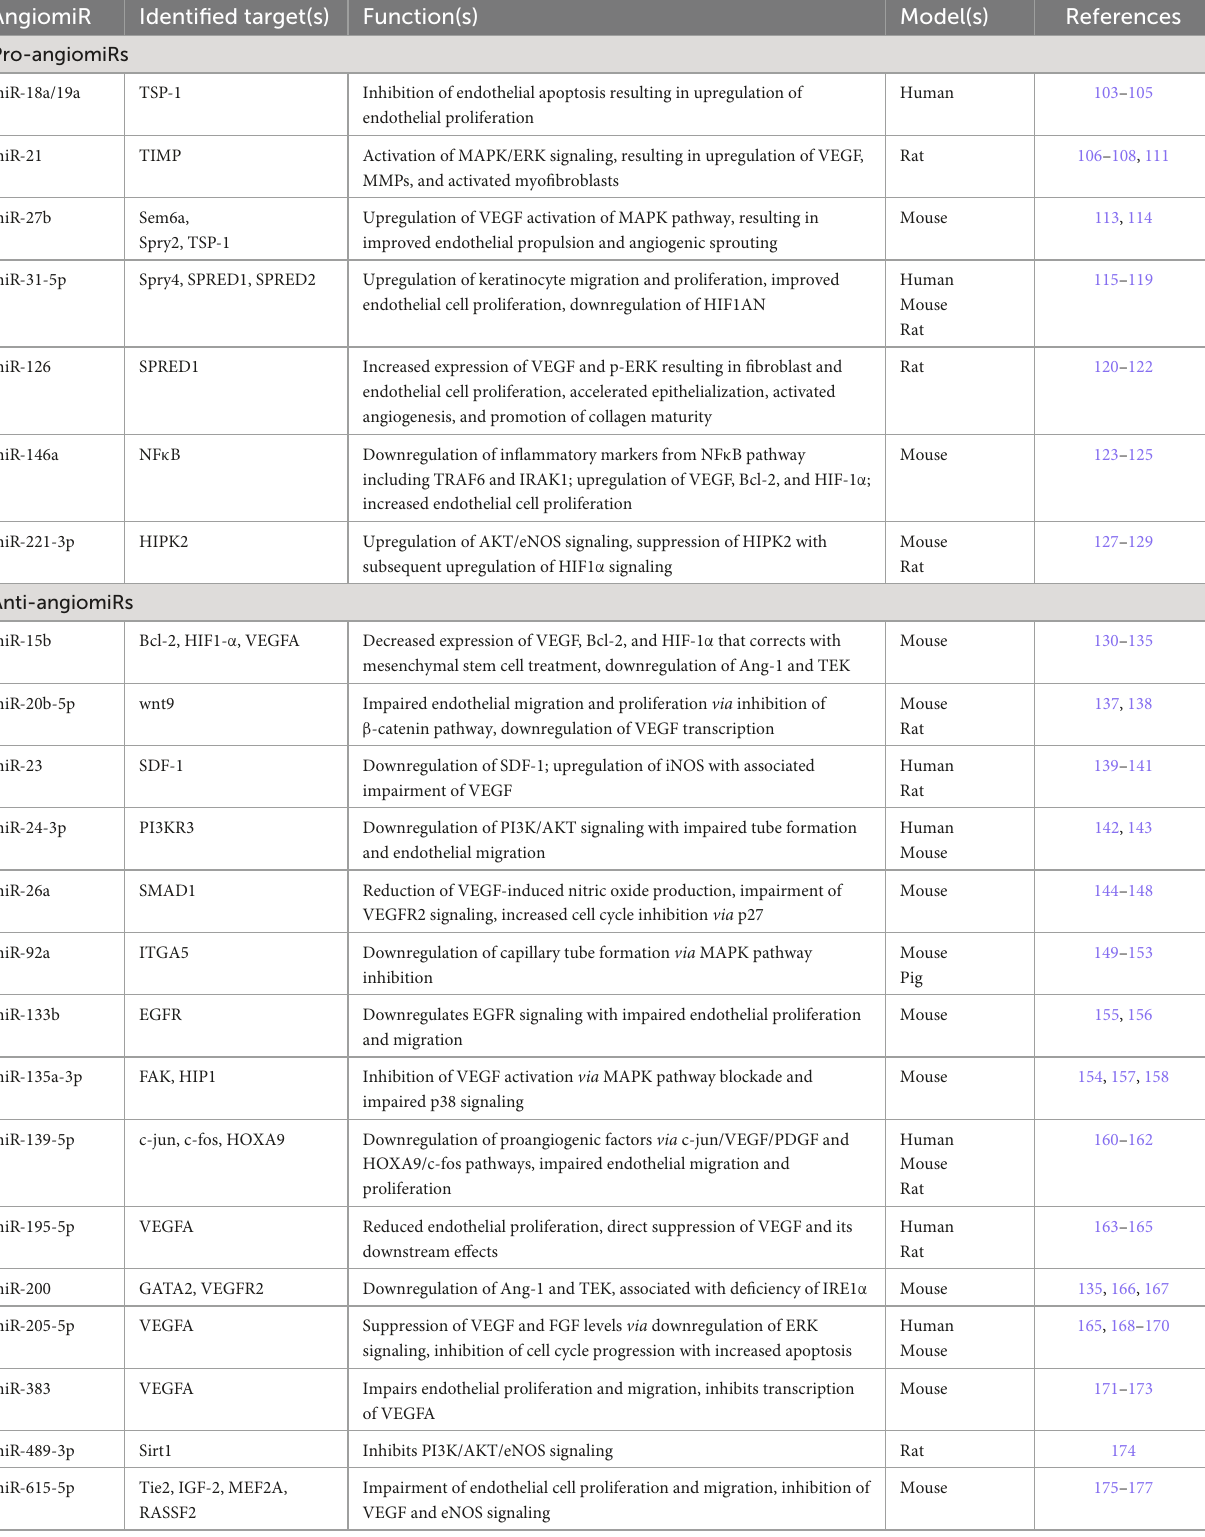
TABLE 1 Pro-angiomiRs and anti-angiomiRs implicated in pathologic angiogenesis in diabetes mellitus, their identified targets, downstream functions, and the diabetic animal or human models in which potential targets and functions have been identified. AngiomiR Identified target(s) Function(s)